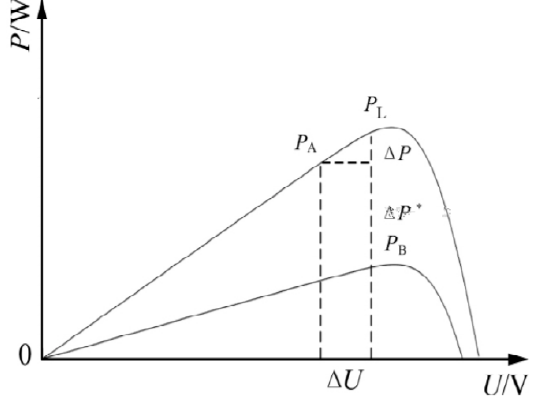
Figure 12. Analysis diagram of misjudgment phenomenon.